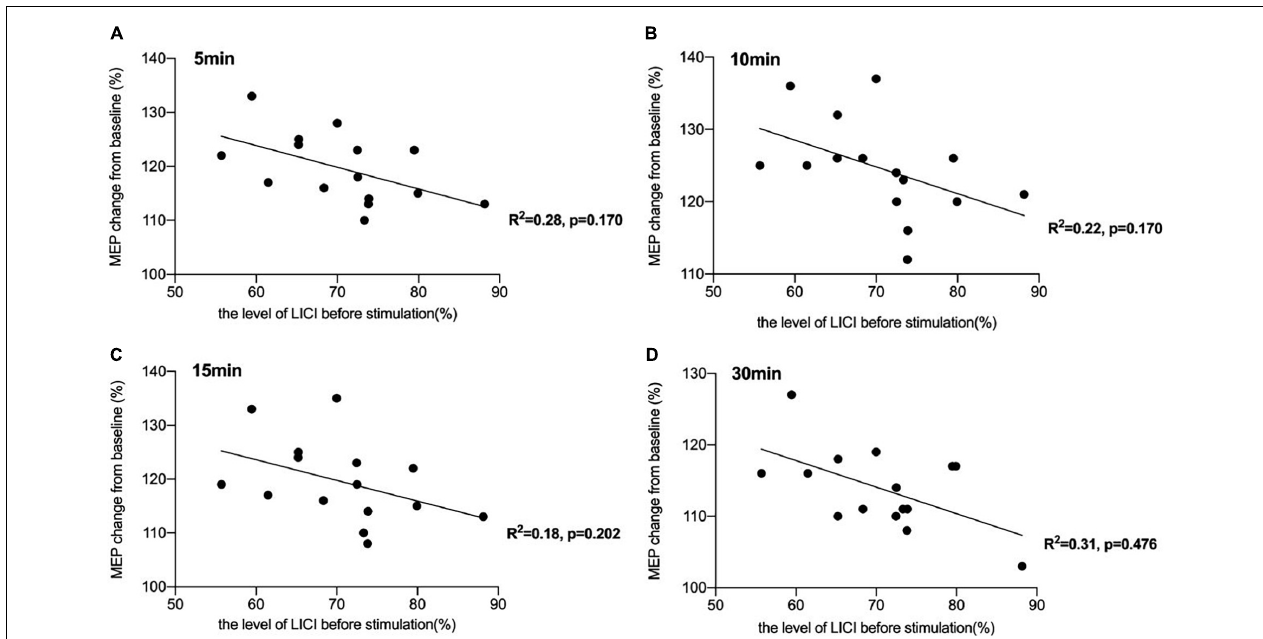
FIGURE 4 | Correlation between long-interval intracortical inhibitory (LICI) and the after-effect of intermittent theta burst stimulation (iTBS)-induced long-term potentiation (LTP)-like plasticity. (A) No significant correlation was reported between the amount of LICI measured before iTBS and the iTBS after-effect at the time point of 5 min [ R 2 = 0.28, p = 0.170, false discovery rate (FDR) corrected]. (B) No significant correlation was also reported between the amount of LICI before stimulation and the iTBS-induced effects at 10 min after stimulation ( R 2 = 0.22, p = 0.170, FDR corrected). (C) The correlation between the level of LICI before stimulation and iTBS-induced after-effects at 15 min after conducting iTBS was also not significant ( R 2 = 0.18, p = 0.202, FDR corrected). (D) There was also no significant correlation between the level of LICI and the after-effect of iTBS-induced LTP-like plasticity at the time point of 30 min ( R 2 = 0.31, p = 0.476, FDR